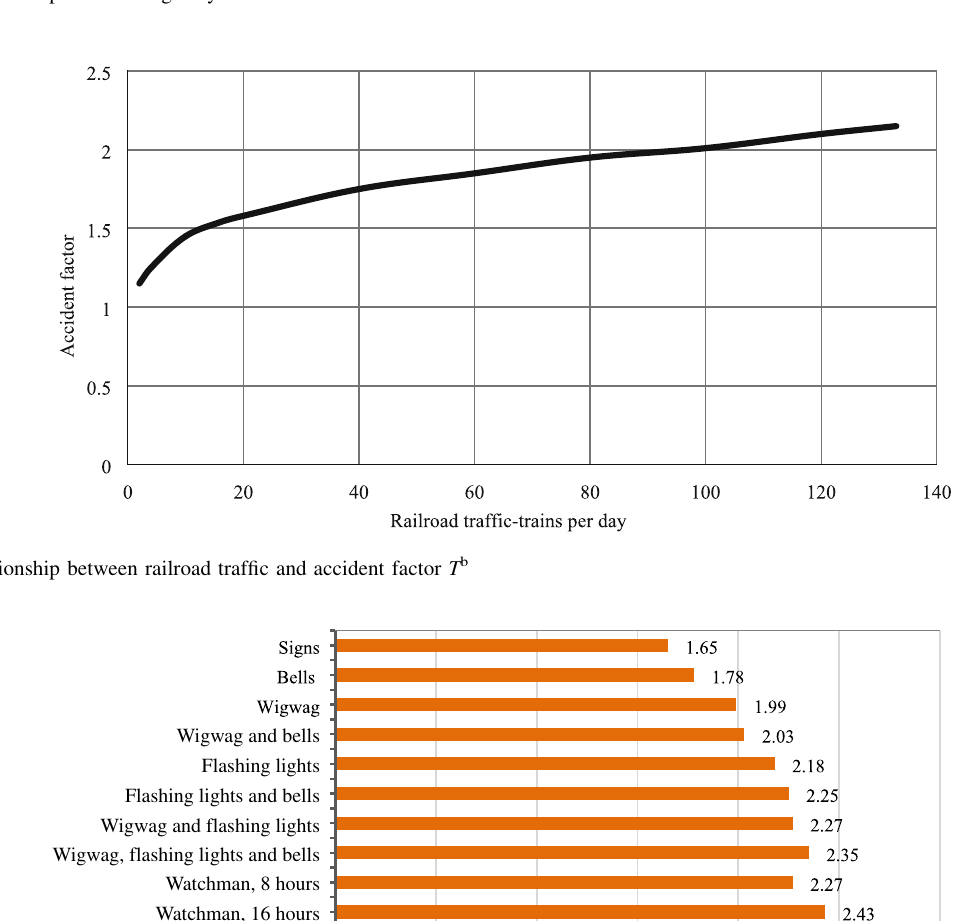
Fig. 4 Relationship between highway traffic and accident factor V a